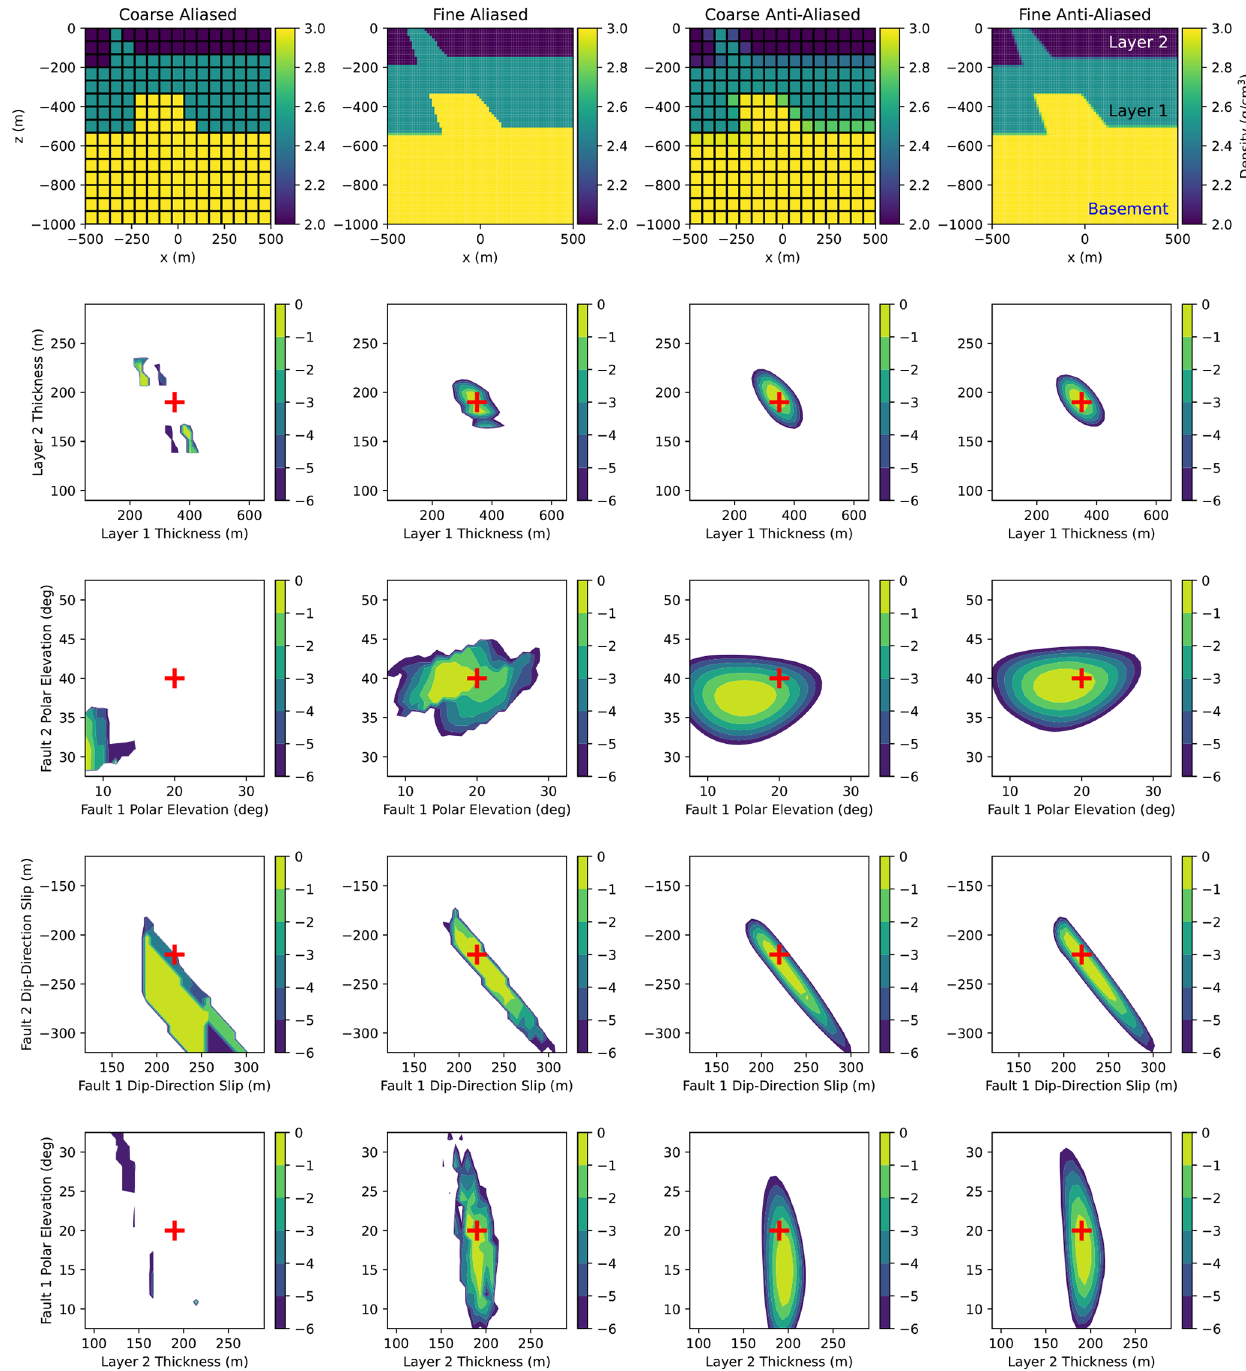
Figure 7. The log posterior distribution of pairs of parameters for Model 6. All plot properties are the same as in Fig.